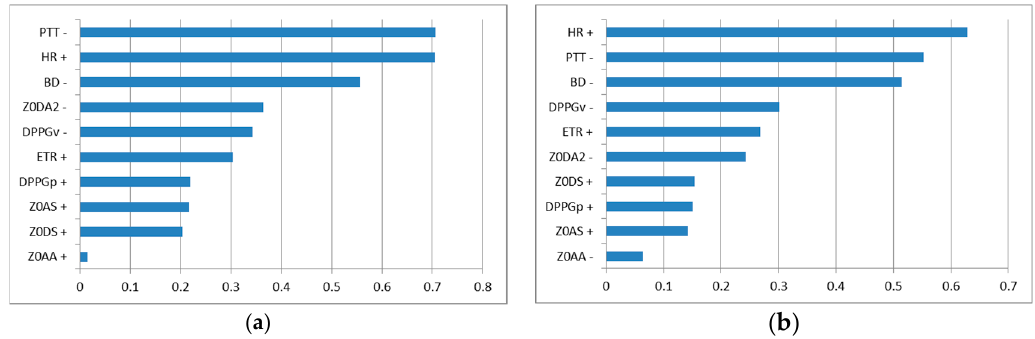
Figure 3. The typical wave of electrocardiogram (ECG) and photoplethysmography (PPG).